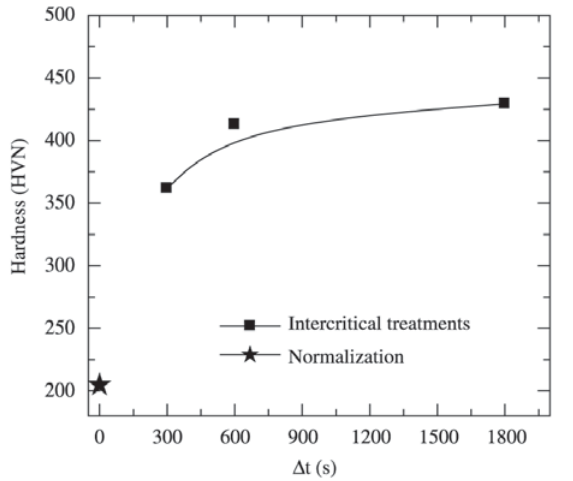
Figure 7. Hardness of samples austenitized at different tempera- tures as a function of the tempering